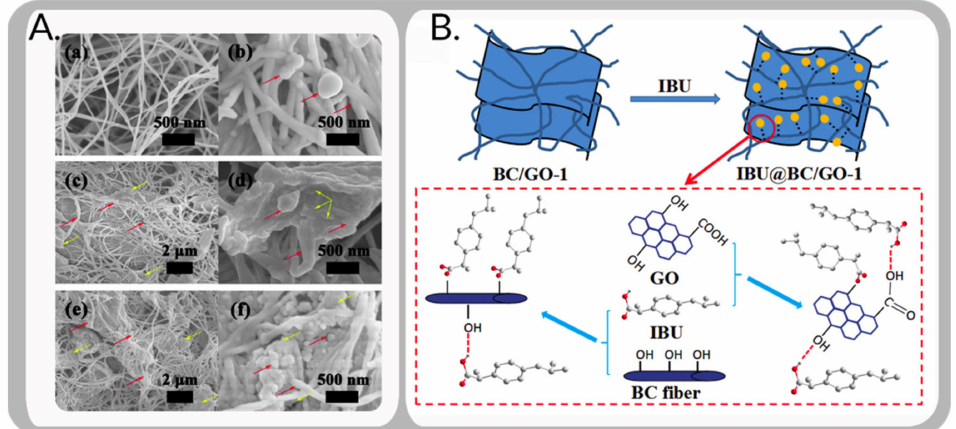
Figure 8. Illustration of bacterial cellulose/graphene oxide nanocomposite as a novel drug deliv- ery system: ( A ) SEM images showing the unique morphological features with the 3D structure: ( a ), IBU@BC ( b ), IBU@BC/GO-1 ( c and d ), and IBU@BC/GO-2 ( e and f ) (red arrows indicate IBU and yellow arrows indicate GO).; ( B ) the mechanism of surface interactions between the BC/GO and IBU drug models. Adapted with permission from